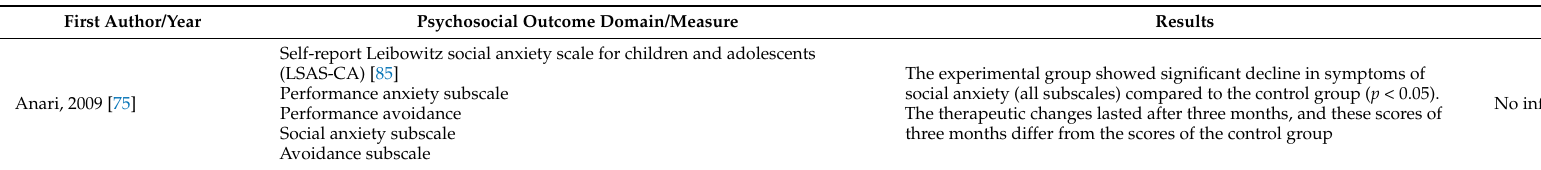
Table 2. Results and description of effects drama therapy